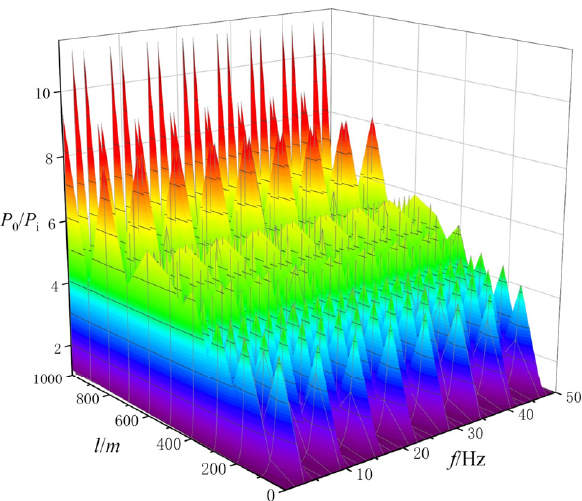
Figure 16. Amplitude–frequency space for different lengths of tubular strings.